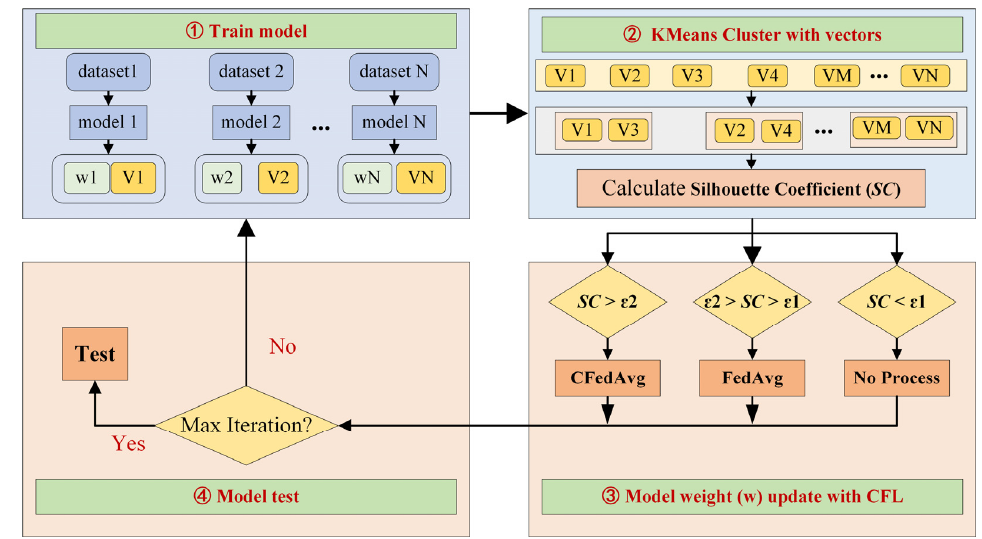
Figure 5. Flow chart of the whole method.